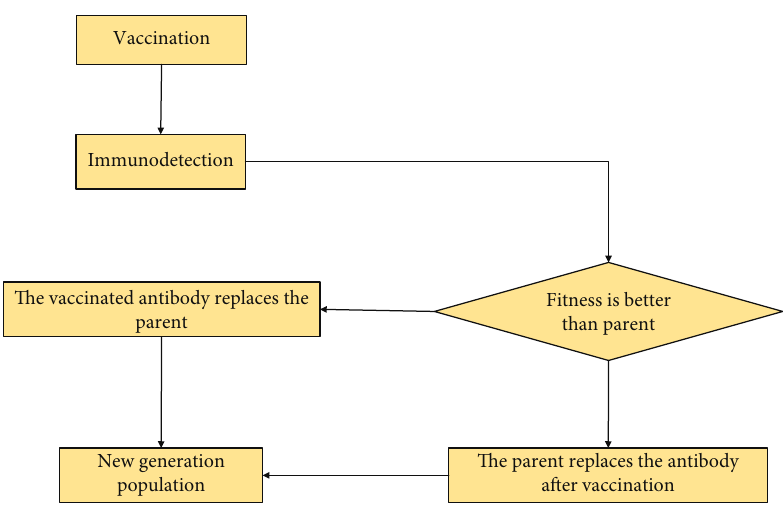
Figure 1: Flowchart of immune genetic algorithm.